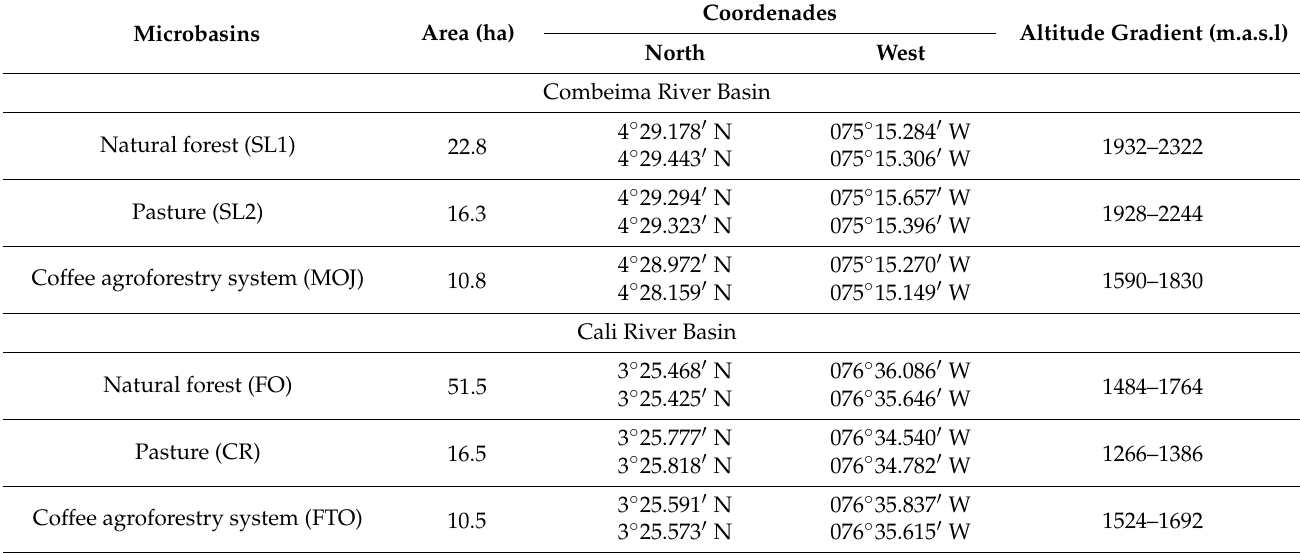
Table 1. Microbasins in the Combeima River basin and Cali River basin. Area, georeferencing and altitude gradient. Microbasins